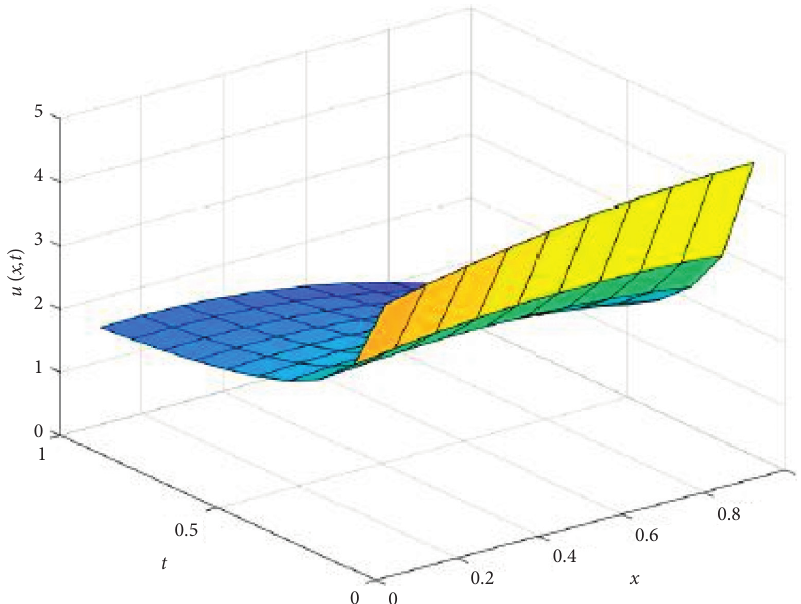
� c � 1, α � 0 . 5, a � 2, and b � 0 1